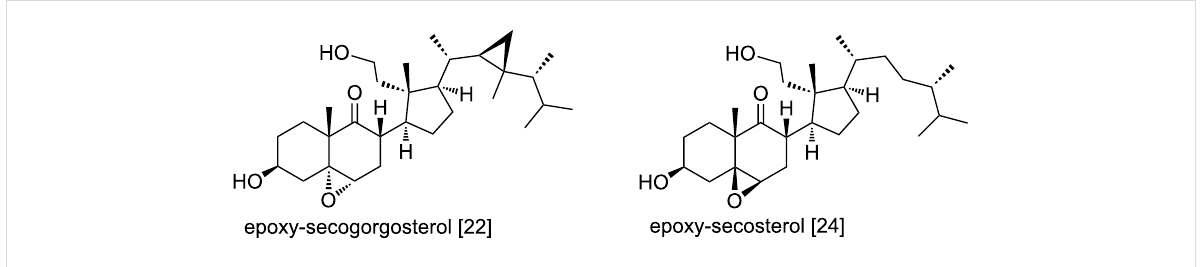
Figure 4: Secosterols [22,24] related to 3 β ,5 α ,6 β -trihydroxy-9-oxo-9,11-secogorgostan-11-ol ( 1 ) from P. longicirrum